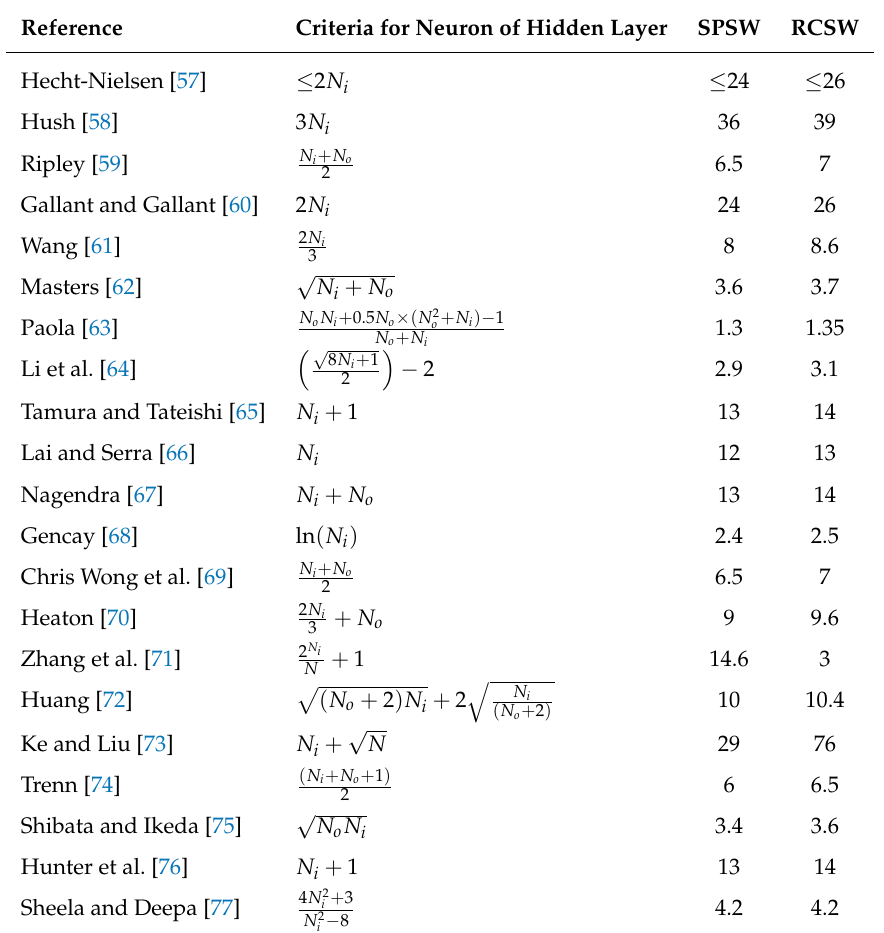
Table 3. A survey on number of the hidden